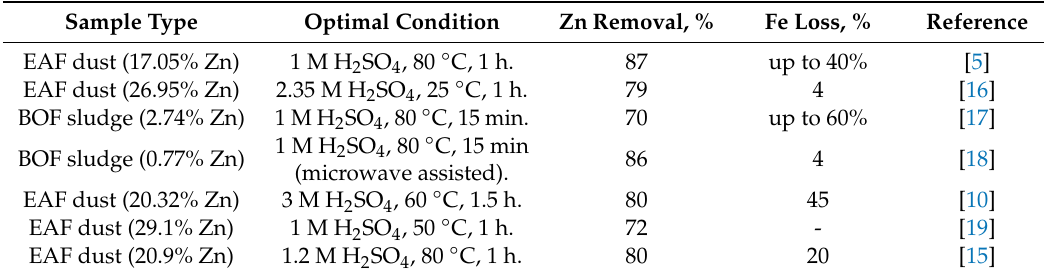
Table 1. Leaching studies for zinc removal base in H 2 SO 4